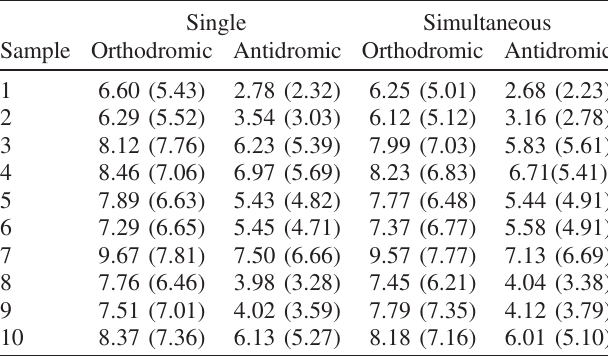
TABLE I. Conduction velocity estimates in m/s from ten different collision experiments on the ventral cord of an earth- worm. All measurements were carried out at 22 (cid:2) 1 °C. The convention is to calculate the velocities by using the first extremum in each pulse recording. Values in parentheses corre- spond to velocities calculated for the nodal point in each pulse that corresponds to the pulse maximum. The recordings belong- ing to sample #7 are shown in Fig. 6.